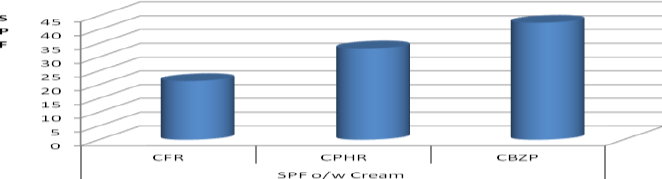
Figure 5. Histogram of SPF evaluation using spectrophotometer Where : CFR = cream with partition compound; CPHR= cream with phalerin; CBZP= cream with